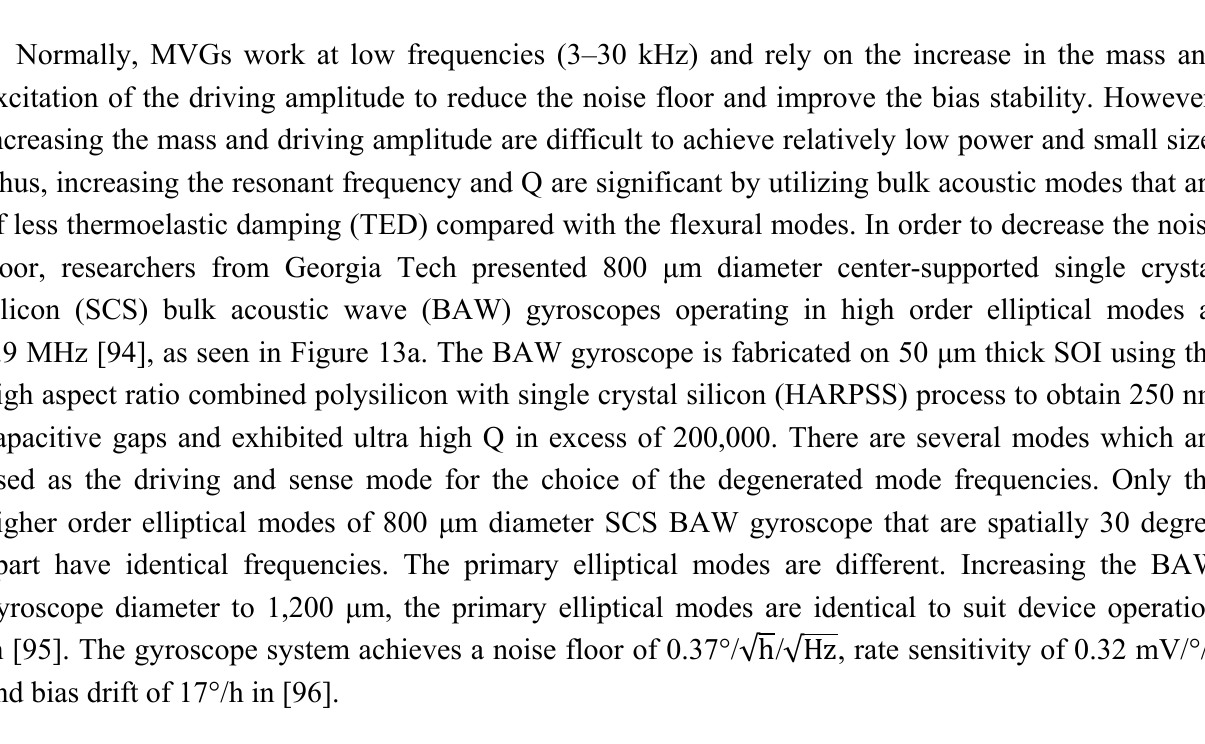
Figure 13. BAW gyroscopes. ( a ), ( b ) and ( c ) Various BAW gyroscopes of Georgia Tech. ( d ) UC